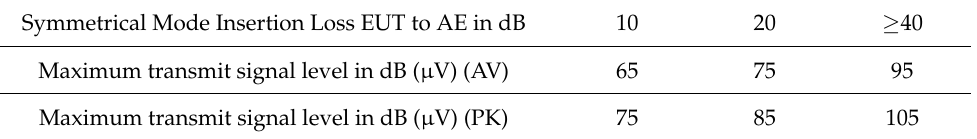
Table 4. Maximum PLC transmit signal level between 1.6065 MHz and 30 MHz. Symmetrical Mode Insertion Loss EUT to AE in